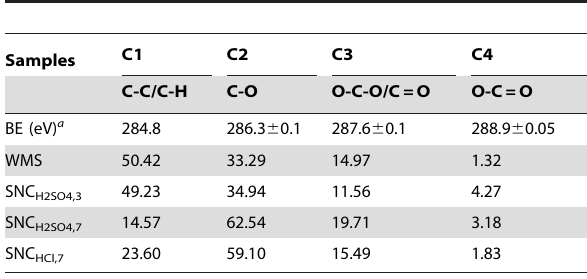
Table 2. Surface functional group composition as obtained from the deconvolution of the C 1 s signal.